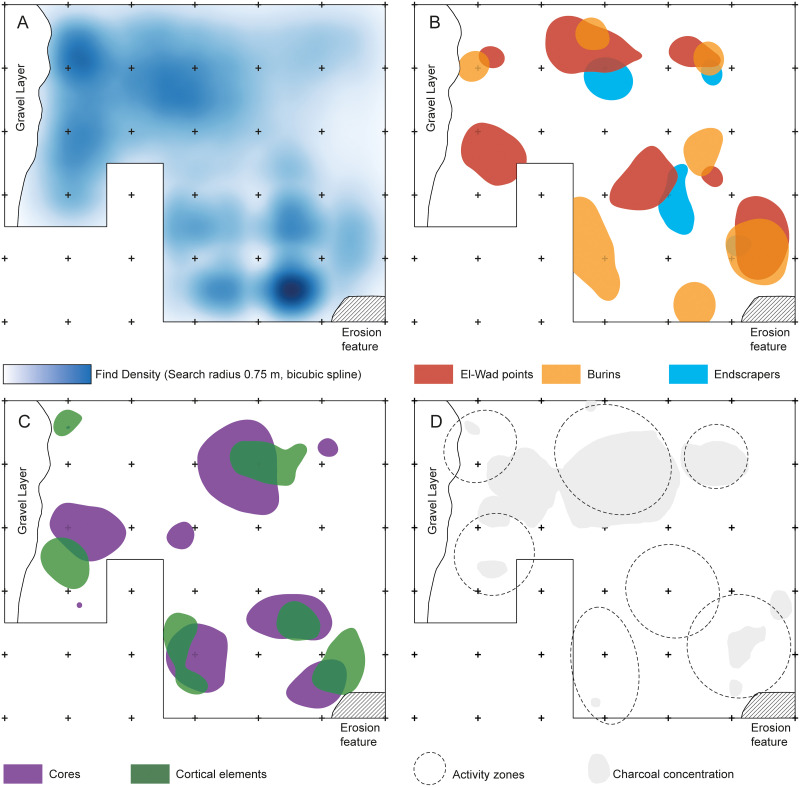
Distribution maps of different artefact classes in Al-Ansab 1.(A) General interpolated find density in the excavation area (B) Clusters of different tool types in the excavation area (C) Clusters of cores and cortical elements in the excavation area (D) Charcoal concentrations and delineated activity zones. Note that remnants of blank production and tool use (A, B, C) each scatter around to the same centres of activity (D) thus indicating 7 events of activity, all producing similar assemblages. Spatial analysis was performed with the Heatmap tool in QGIS 2.18. Clusters were identified based on selected isolines from computed kernel density estimates. Spatial data covers the field campaigns from 2015 to 2018.